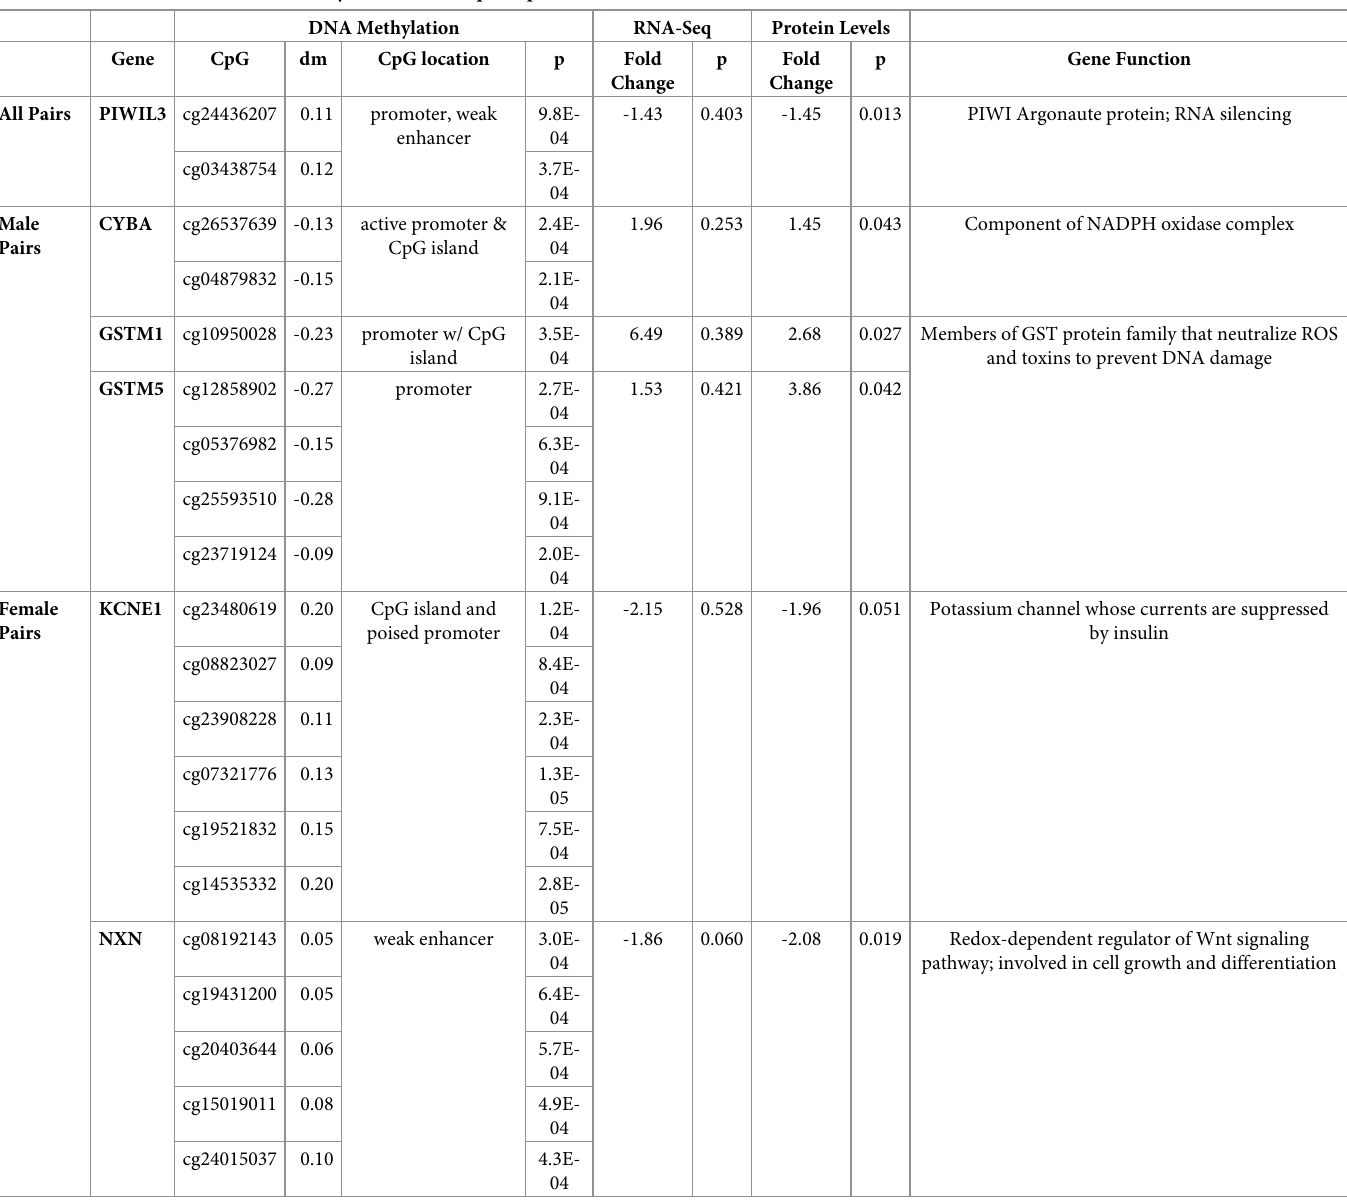
Table 4. Correlation between DNA methylation, RNA-Seq, and protein